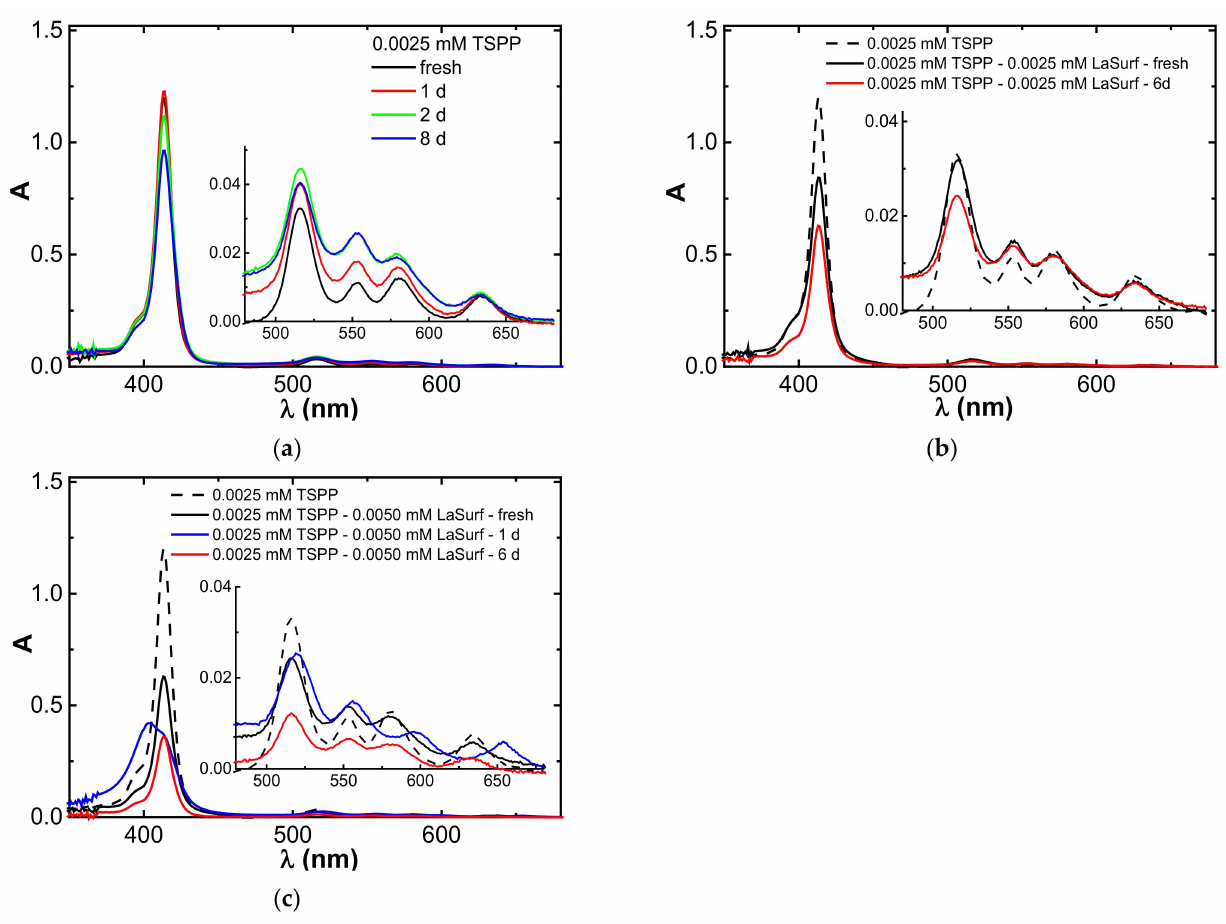
Figure 7. Changes of UV spectra of the Soret band and Q bands (inset) of pure 0.0025 mM TSPP ( a ) and mixed systems TSPP:LaSurf = 1:1 ( b ) and 1:2 ( c ) with time (H 2 O, 25 ◦ C, 1 cm